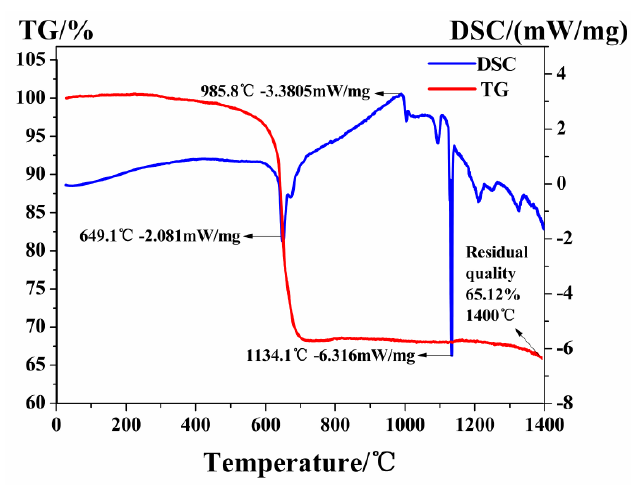
Figure 2. Differential scanning calorimetry (DSC)/thermogravimetry (TG) curve of Li 2 CaGaO 4 .